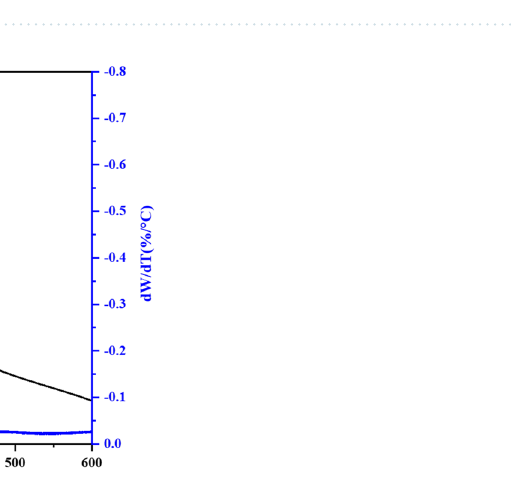
Figure 10. ( a ) XPS spectrum of Fe-Ben/PVP-DVB/Pd nanocatalyst. ( b – d ) High-resolution XPS spectra of Fe 2p, Pd 3d, and C1s.